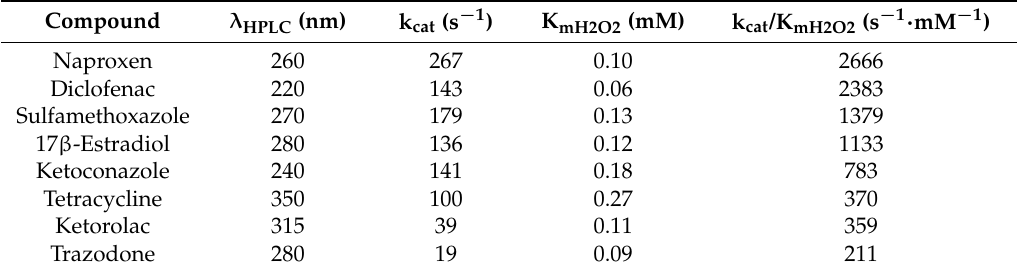
Figure 1. Time course curves of the oxidation of the eight pharmaceutical compounds (PhCs) by chloroperoxidase (CPO). Table 1. Catalytic parameters of the oxidation of PhCs by CPO